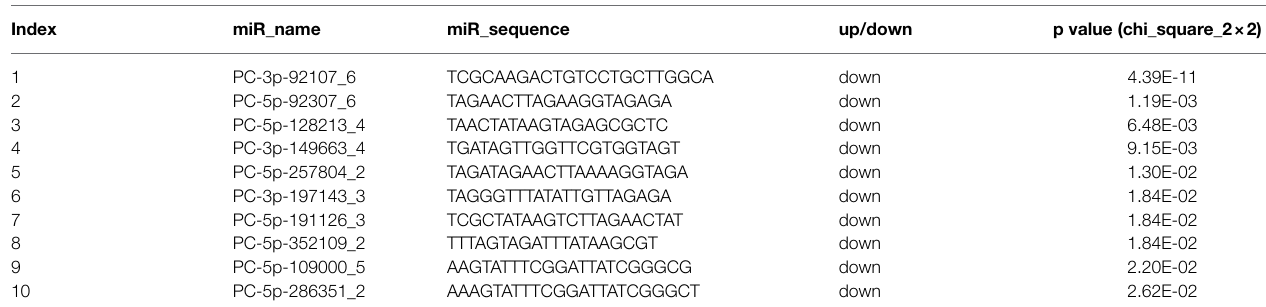
TABLE 1 | DCL2-dependent milRNAs isolated from V.